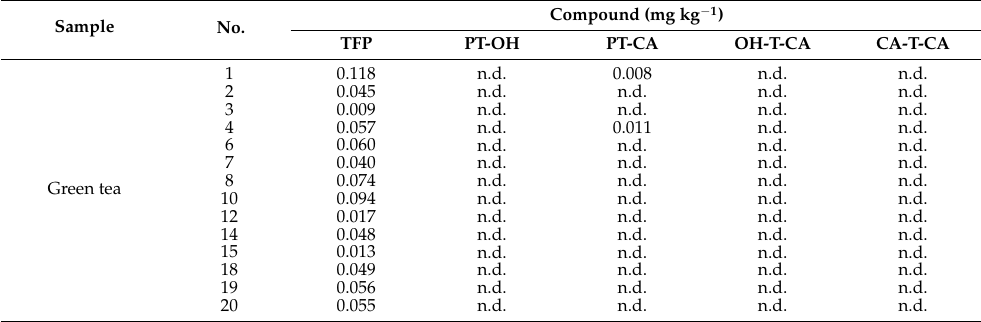
Table 5. The residual level of TFP and its metabolites found in different batches of green and black tea samples (mg kg − 1